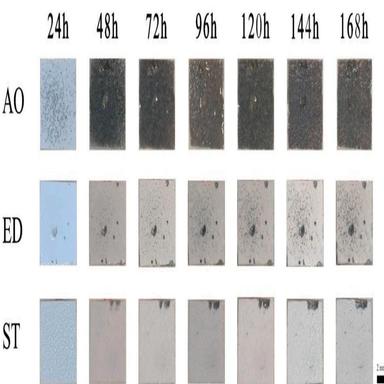
Surface morphology photos of three prepared samples during immersion in SBF for 168 h.